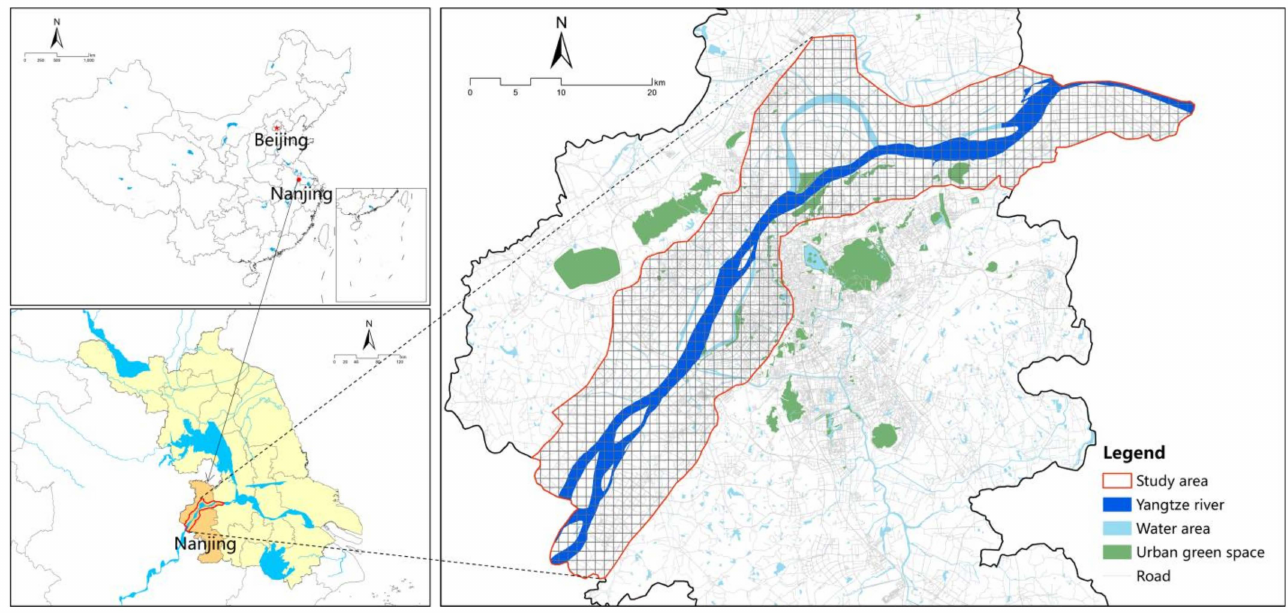
Figure 1. Study area: urban waterfronts along the Yangtze River in